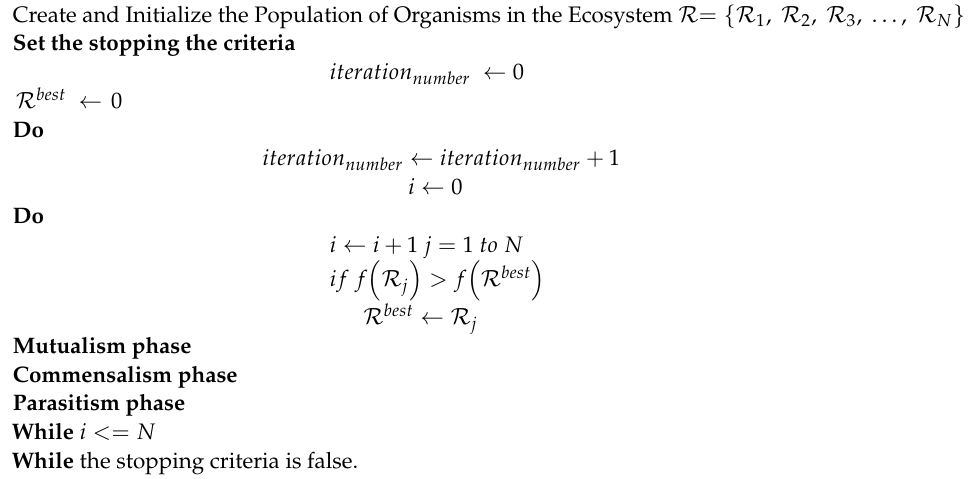
Algorithm 1: Traditional Symbiotic Organisms Search